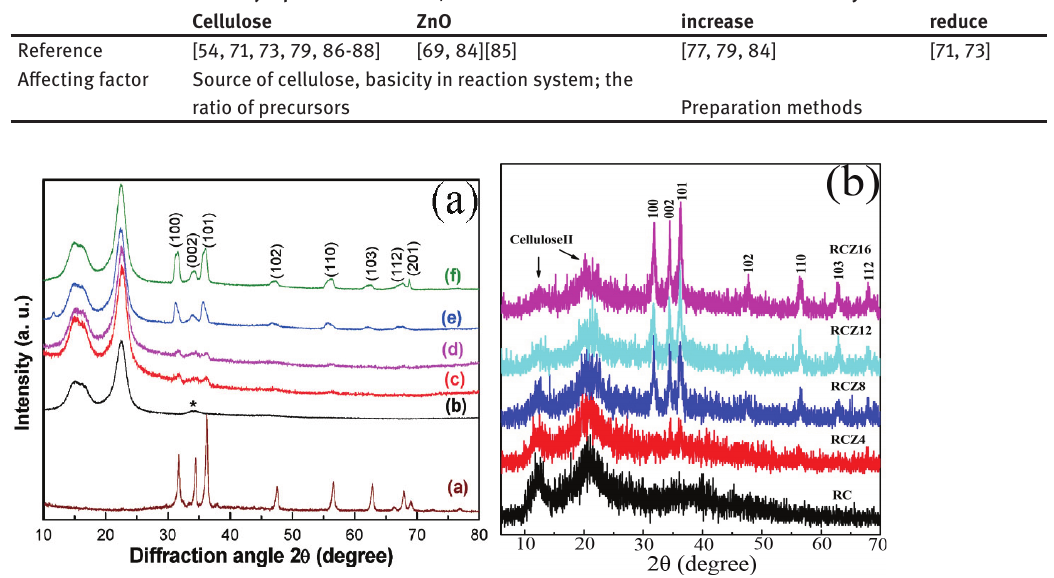
Figure 2: The XRD plots of cellulose/ZnO (a): Cellulose as major phase in composites [54]; (b): ZnO as major phase in composites [69].